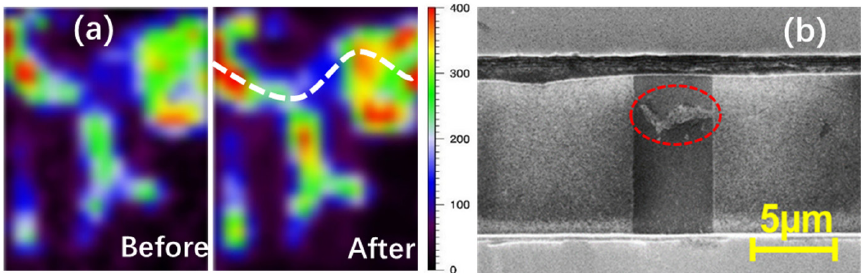
Figure 20. ( a ) D-peak intensity in a Raman spectrum for a graphene ribbon sample before and after TLP zapping failure, which illustrates defect development, leading to ESD failure; ( b ) SEM image shows the failure signature, which is a fault line across the graphene wire after ESD zapping breakdown.